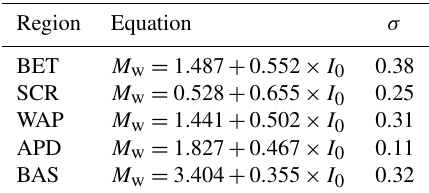
Table 2. Empirical relations between epicentral intensity I 0 and M w defined in each calibration region from Stucchi et al. (2013) except that of APD, from Rovida et al. (2020b). APD: Apennines, north-eastern Alps and Dinarides; BAS: broad Aegean, shallow; BET: Betics; SCR: stable continental region; WAP: Western Alps and Pyrenees.